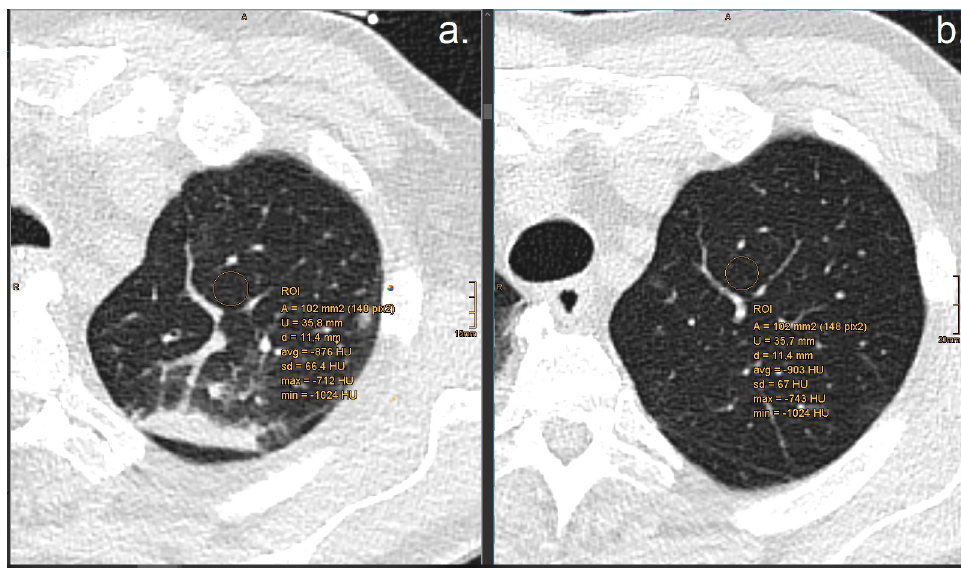
Fig 3. ROI measurements. Manual ROI measurements in the left upper lobe of a 45-year-old woman with COVID 19 pneumonia at initial CT scan (a.) and at follow-up CT scan after 45 days (b.), a decreasing in attenuation values by -27 HU can be seen between initial scan and